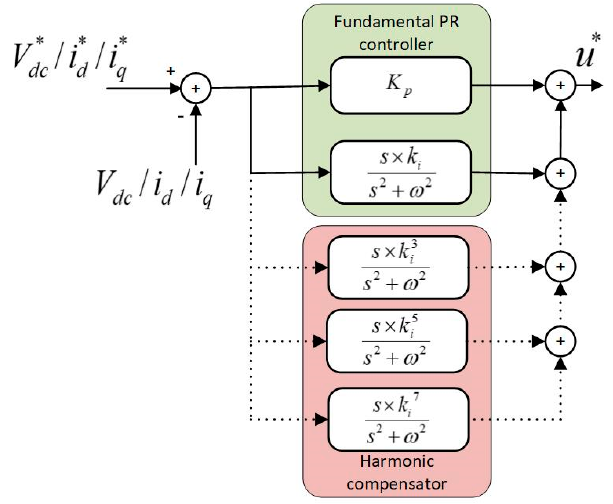
Figure 7. Combined structure of PR with harmonic compensator.